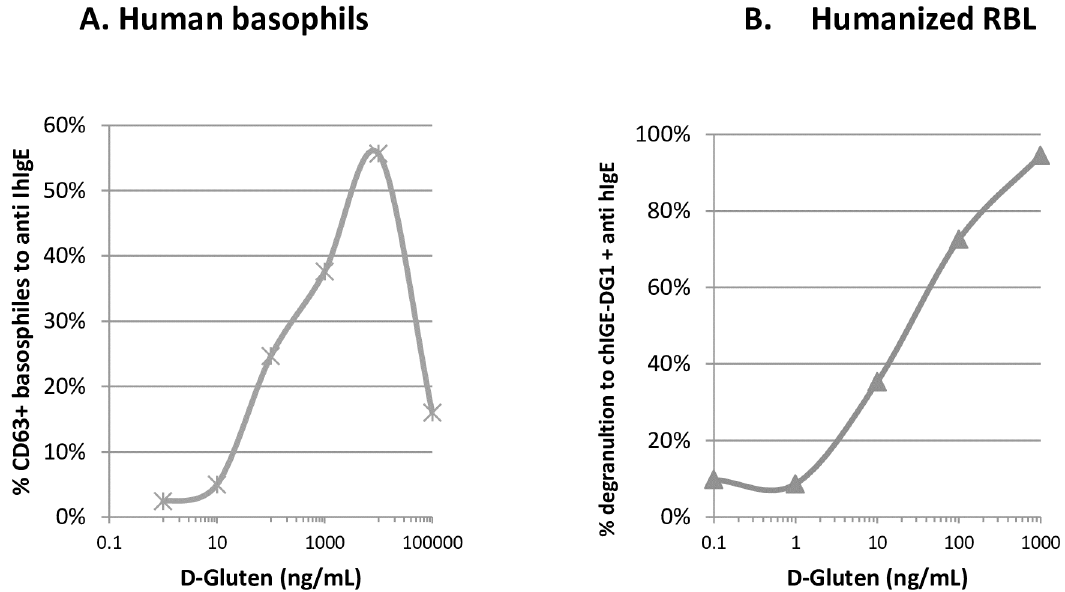
Fig 5. Chimeric mouse/human IgE-DG1 functionality on human basophils. A. Basophils from 2 humandonors were passivelysensitizedwith chIgE-DG1 and subsequently cross-linkedwith anti-humanIgE antibodies or 6 doses of D-Gluten. For each D-Gluten dose, the mean percentageof CD63 + cells was monitored by flow cytometry and compared to the percentage of CD63 + cells inducedby anti-humanIgE. B. D-Gluten, Deamidated Gluten.